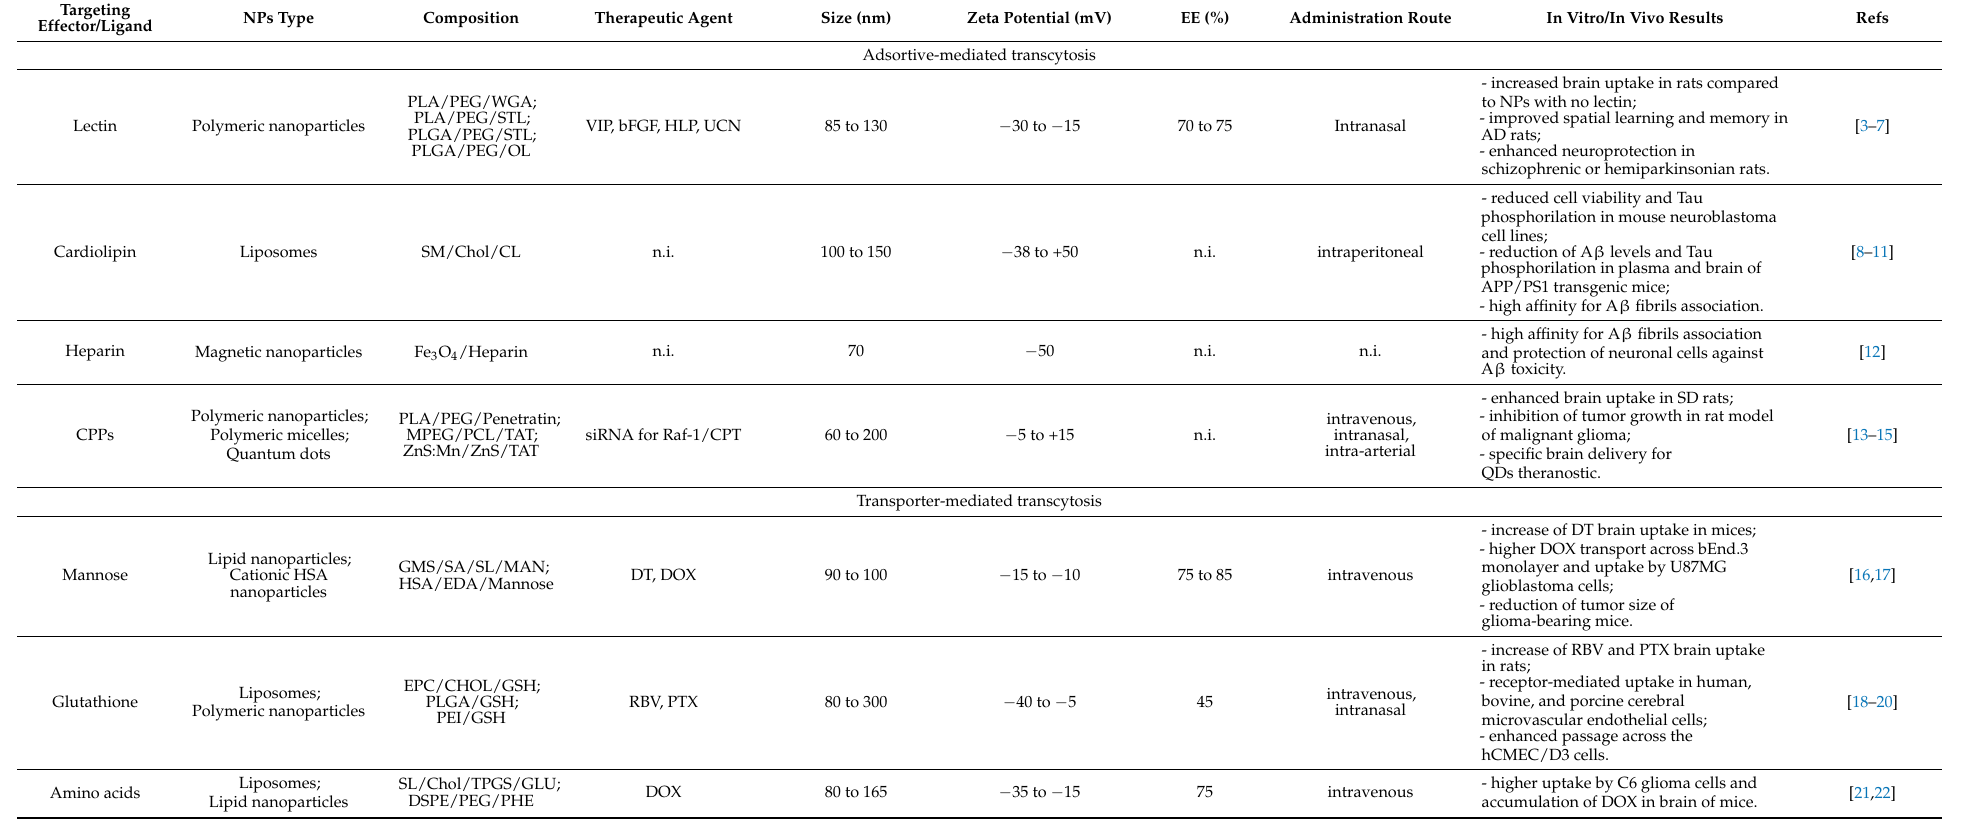
Table 1. Types of actively targeted nanoparticles used for brain